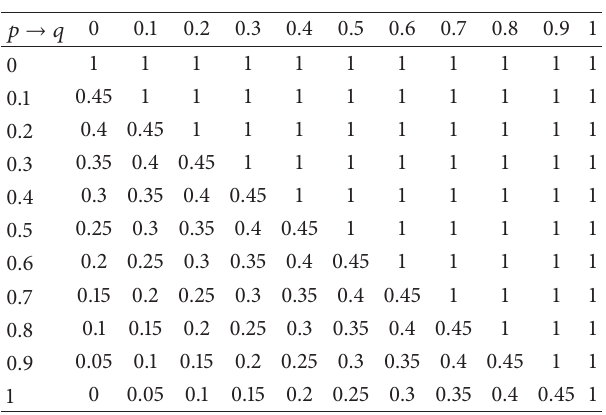
be the minimal and maximal diameter of the convex hull ch (𝐴) of 𝐴 ⊆ Dom, respectively. The convex hull regularizes the sets A and B and eliminates irregularities. 𝑐(𝐴) denotes the centroid of ch (𝐴) , and 𝑅 𝛼 denotes the rotation matrix by angle 𝛼 (Figure 1(a))